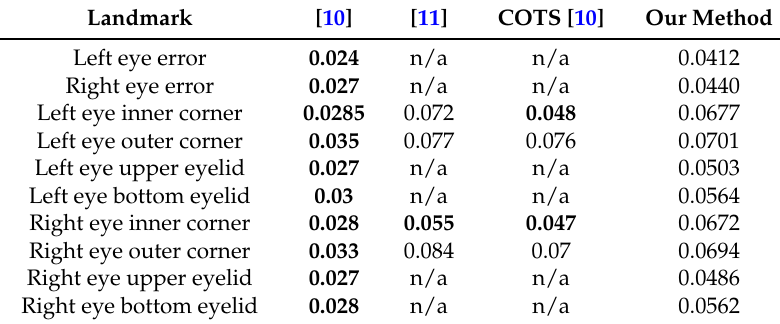
Table 5. Mean error normalized by the inter-pupillary